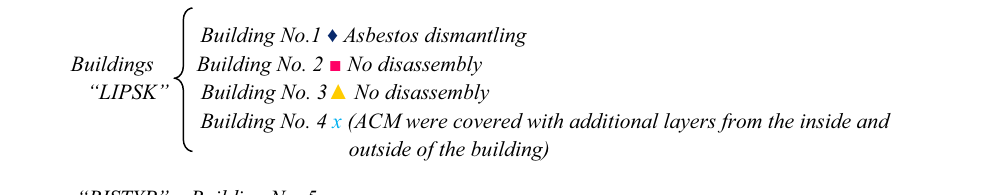
Figure 5. Contamination comparison in rigid (“BISTYP”) and non-rigid structures (“LIPSK”). ( a ) The reduction of the rate of change in the concentration of asbestos dust over a period of time, after reaching a concentration of < 400 f/m 3 . This applies to objects operated in the same way for longer periods of time without damaging the ACM. The vertical axis corresponds to dust concentrations on a logarithmic scale. The horizontal axis denotes the time when measurements were taken (weeks) on a linear